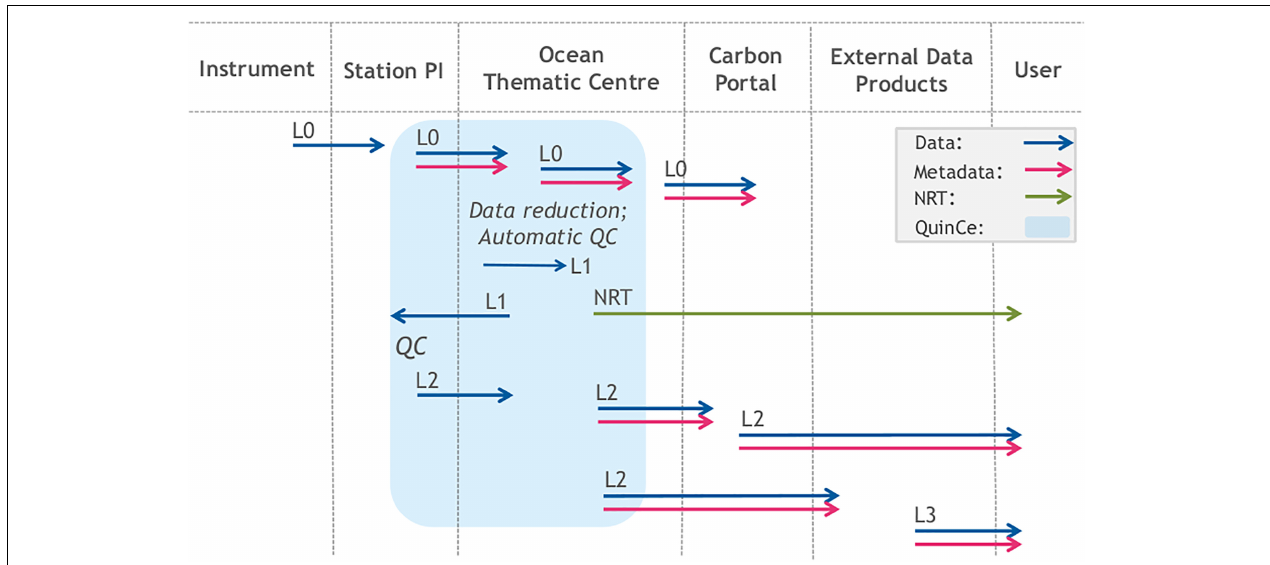
FIGURE 6 | ICOS OTC Data life cycle, showing flow of data (blue arrows) and metadata (red arrows) between instrument, station PI, OTC, CP, producers of external data products, and final users, for Level 0 through 3 and NRT data. The processes in which the automated data QC and data reduction technique QuinCe is involved, is shown as a light blue